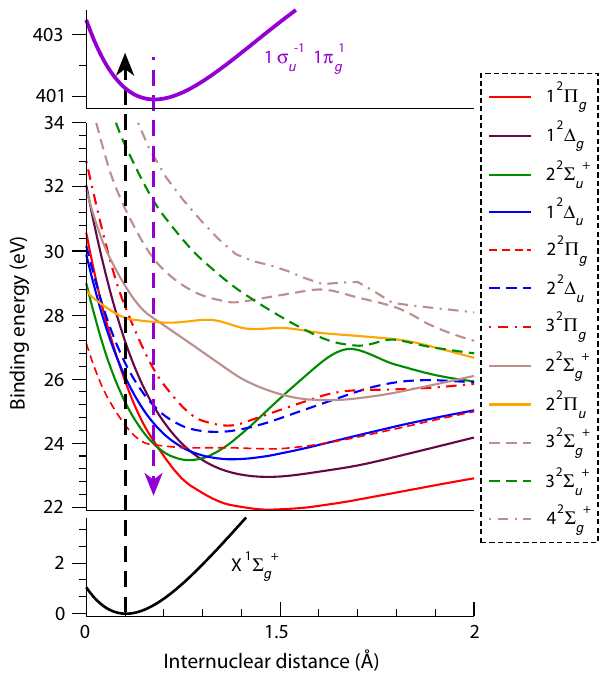
FIG. 2. Ab initio potential-energy curves of the ground (lower panel), intermediate (upper panel), and relevant final states (middle panel). The centers of the Franck-Condon regions for the transition from the ground and core-excited states are shown by the vertical dashed